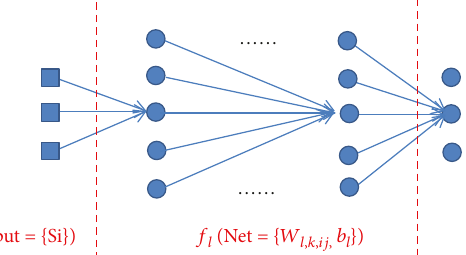
Figure 2: Basic structure of neural